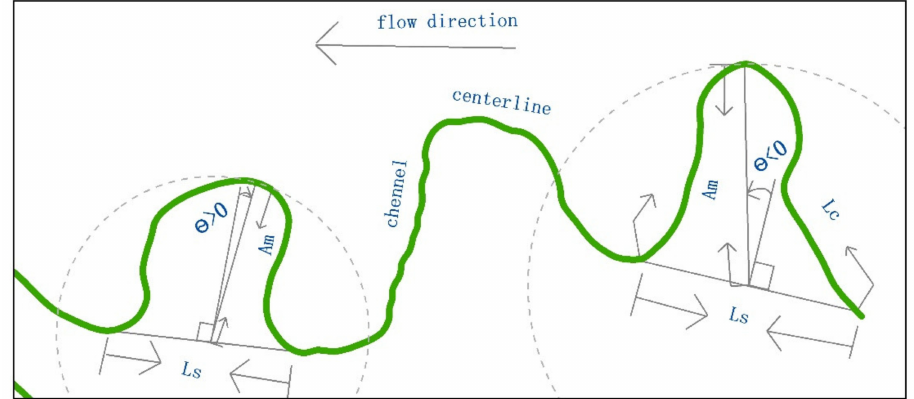
Figure 2. Channel planform geometric parameters. Meander Amplitude (Am) is the maximum distance from the down-valley axis to the sinuous axis of a meander loop. Wavelength (Ls) is the length between the troughs or crests of a meander. Direction angle ( Ѳ ) shows the angle between the path and the down- valley direction. were manually obtained through the identification of the peak and valley positions from the group points. The length of Am, Ls, and Lc and the direction angle ( Ѳ ) were automat- ically measured by the ArcGIS tool.